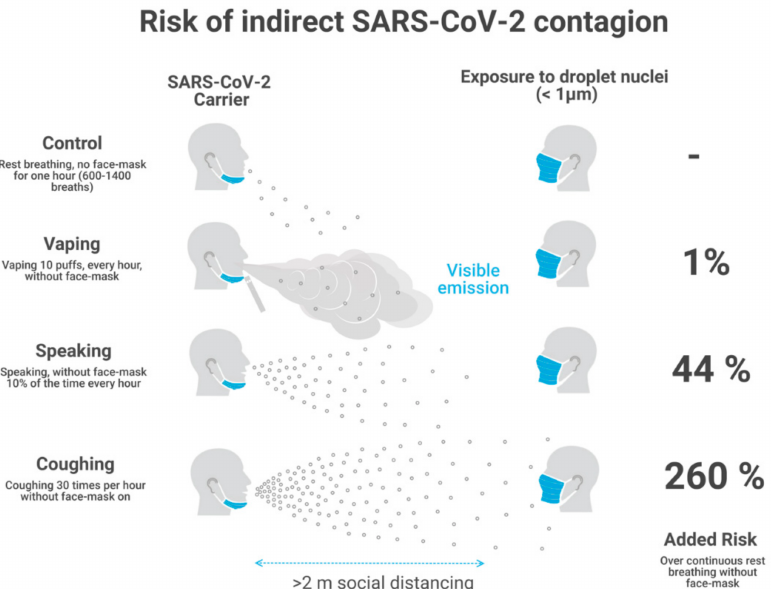
Figure 1. Direct and indirect exposure to various respiratory activities. The figure displays a sketch of the area of direct exposure for droplet emitters not wearing a face mask and masked bystanders. Notice that the flow of droplet emission is visible only for vaping, making it easy for bystanders to avoid direct exposure to it. The percentages in the right hand side denote risks of indirect exposure with respect to the control state of continuous